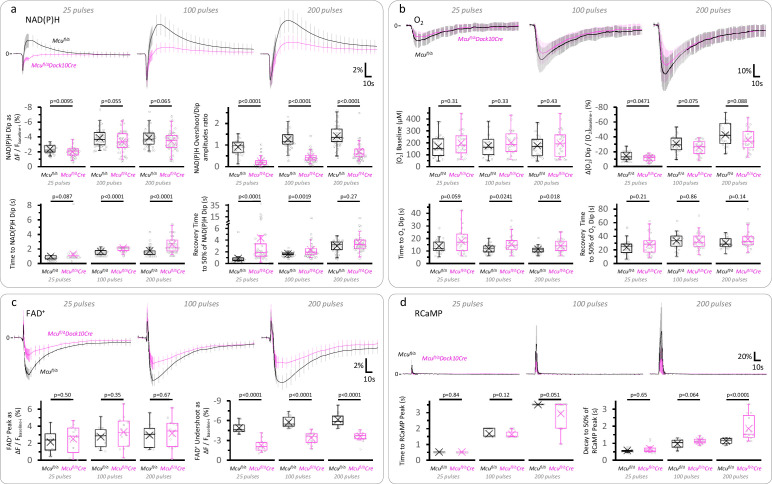
The initial dip of the NAD(P)H signal, the overall FAD+ signal, and the O2 dip in response to stimulation, are less affected than the slow NAD(P)H overshoot in DGCs from Mcufl/Δ Dock10Cre mice.(a) Average traces of the NAD(P)H signal expressed as the ΔF/Fbaseline-i ratio (mean ± SD of number of slices, sample sizes as in Figure 3b, Right panel). The initial dip of the NAD(P)H signal was marginally affected in Mcufl/Δ Dock10Cre mice compared to Mcufl/Δ mice, despite a marked attenuation of the NAD(P)H overshoot. The lack of MCU also prolonged the time to the initial dip and delayed the recovery of the fluorescence after reaching a minimum upon stimulation, likely reflecting less overlap between the oxidative and reductive phases of the NAD(P)H signal due to the attenuation of the overshoot. (b) The dip in tissue [O2] following the stimulation of the layer of DGCs was marginally decreased in Mcufl/ΔDock10Cre mice (25 pulses: Nslices = 26, Nmice = 13; 100 pulses: Nslices = 27, Nmice = 14; 200 pulses: Nslices = 29, Nmice = 14), when compared to Mcufl/Δ mice (25 pulses: Nslices = 27, Nmice = 15; 100 pulses: Nslices = 28, Nmice = 15; and 200 pulses: Nslices = 27, Nmice = 15). (c) The late decrease in the FAD+ signal (the ‘Undershoot’) was less attenuated than the NAD(P)H overshoot in DGCs from Mcufl/ΔDock10Cre mice (Nslices = 13, Nmice = 8 for all stimulations), when compared to Mcufl/Δ mice (Nslices = 13, Nmice = 6 for all stimulations). (d) The time course of the cytosolic RCaMP1h signal in response to stimulation was very similar between both groups, except for a ~ 1.65-fold increase in the decay time to 50% of the peak of Mcufl/ΔDock10Cre mice (Nslices = 13, Nmice = 8) versus Mcufl/Δ mice (Nslices = 13, Nmice = 6), when stimulating with 200 pulses. For the reasons described in the legend of Figure 3—figure supplement 2 regarding the variability in sensor expression levels, here we focused on the kinetics of the signal and later assessed the magnitude of the [Ca2+]CYT spike in 2p-FLIM experiments. A Student’s t test or a Welch’s t-test were used for comparisons between normally distributed data, or a non-parametric Mann-Whitney test was used otherwise.